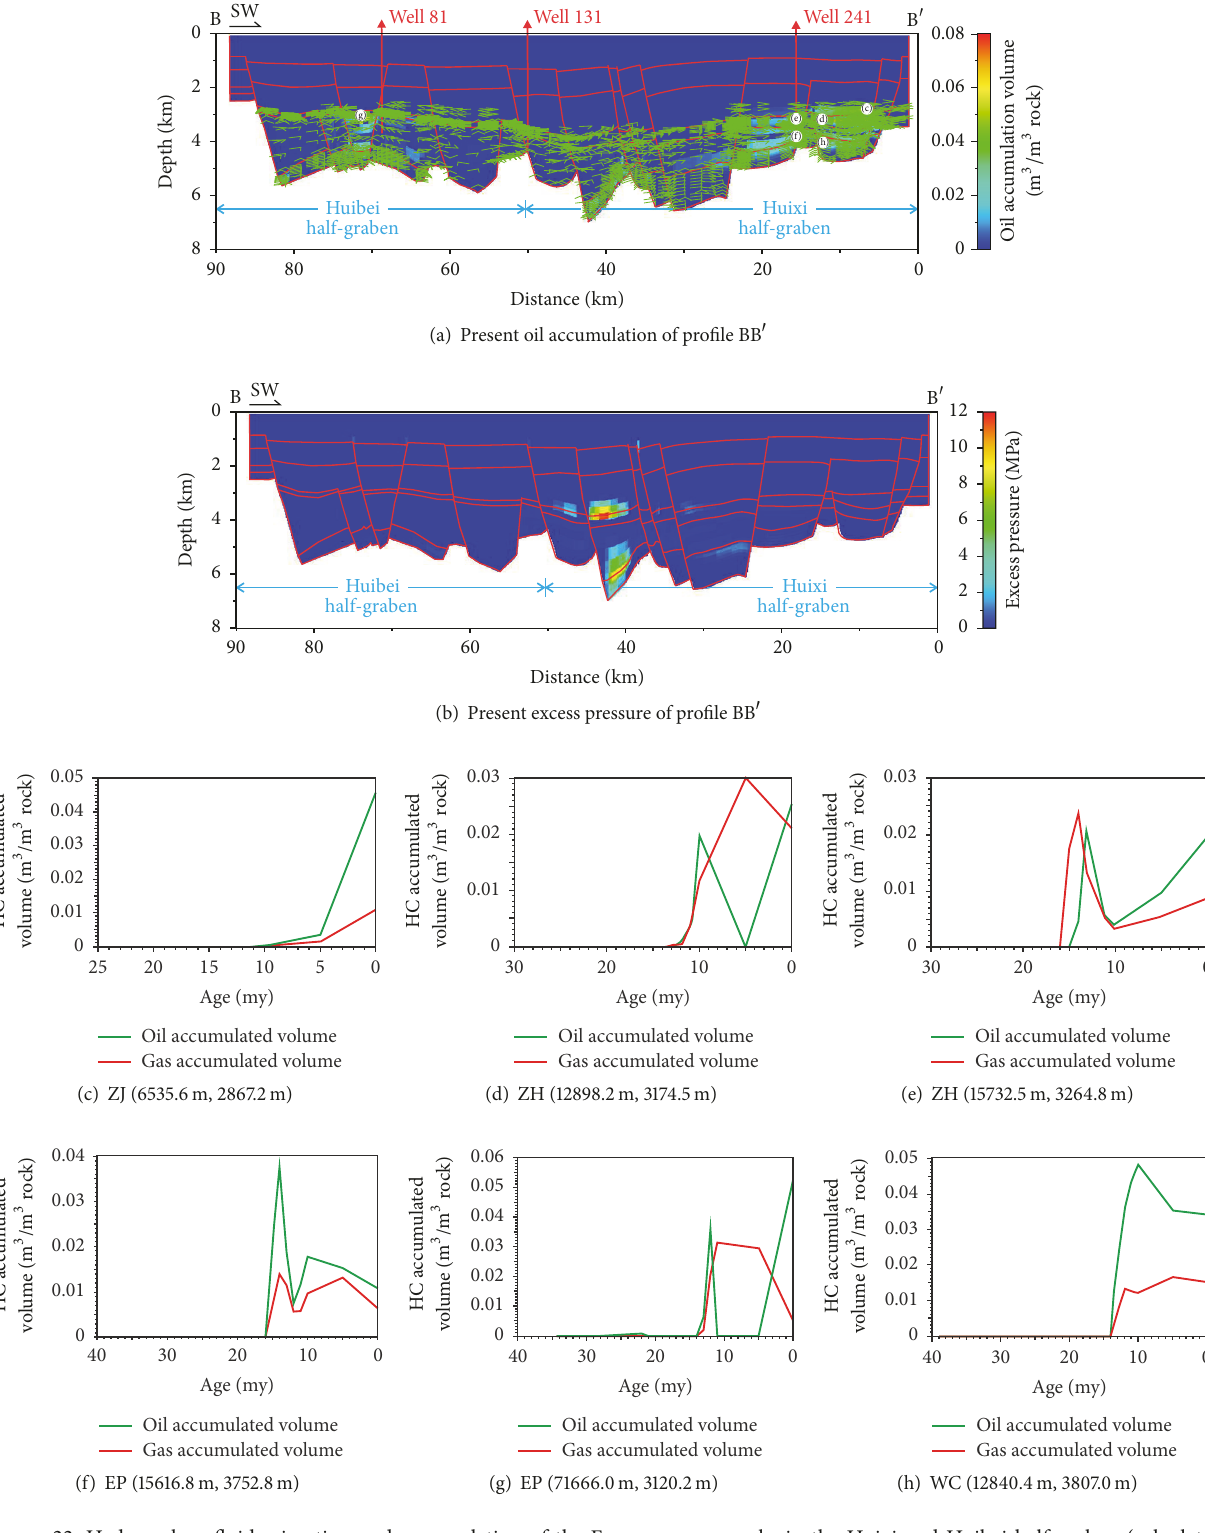
Figure 22: Hydrocarbon fluid migration and accumulation of the Eocene source rocks in the Huixi and Huibei half-graben (calculated hydrocarbon volume is expressed in reservoir condition. The locations of three wells and profile BB 󸀠 are shown in Figure